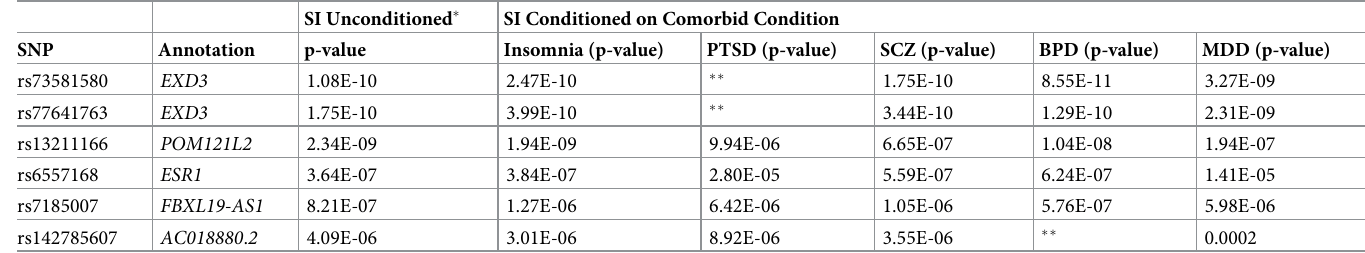
Table 4. Genome-wide Significant Loci for Suicidal Ideation Conditioned on Comorbid Conditions. SI Unconditioned � SI Conditioned on Comorbid